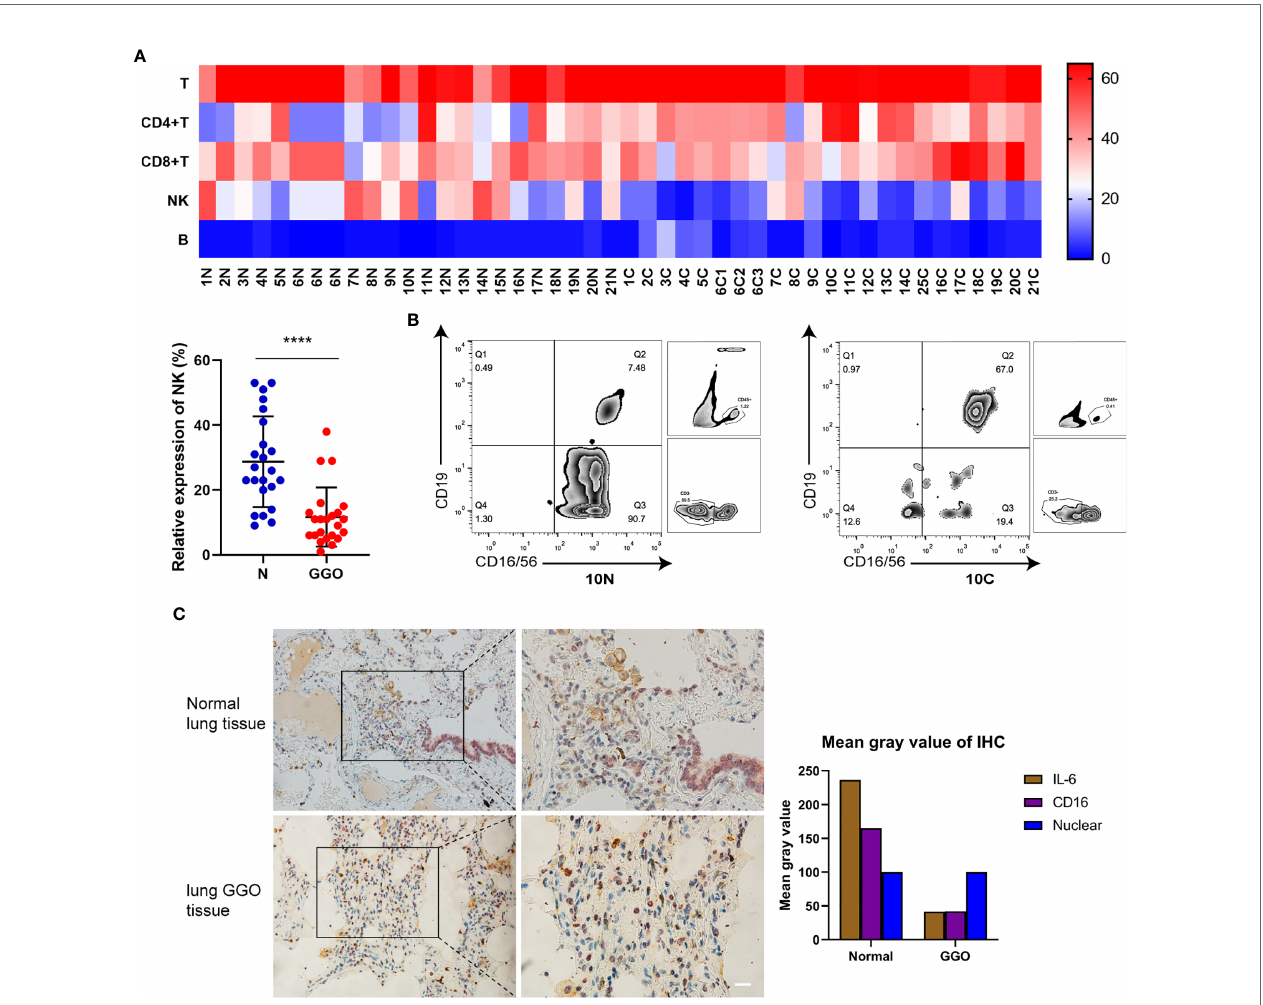
FIGURE 3 | The decrease of NK cells in lung adenocarcinoma with GGO. (A) The fl ow cytometry result of immune cells. The heatmap shows the expression status of 5 kinds of cells in 21 GGO patients (upper), and the scatter plot shows the expression of NK cells (lower). (B) The expression of NK cells (CD16/CD56+) on total CD45+CD3- cells within the lymphocyte gate from one representative patient with paired normal (left, 10N) and GGO (right, 10C) tissues. In the paired samples selected, NK cells in normal lung tissues made up about 90.7% of all non-T lymphocytes, while the content in GGO tissues was 19.4% around. (C) The multiple staining immunohistochemical results of IL-6 (in brown) and CD16 (in purple) in normal lung tissue or GGO lung tissue. Each dot represents an individual patient. Results are expressed as mean ± SEM. ****P<0.0001. N, normal; C, cancer. Scale